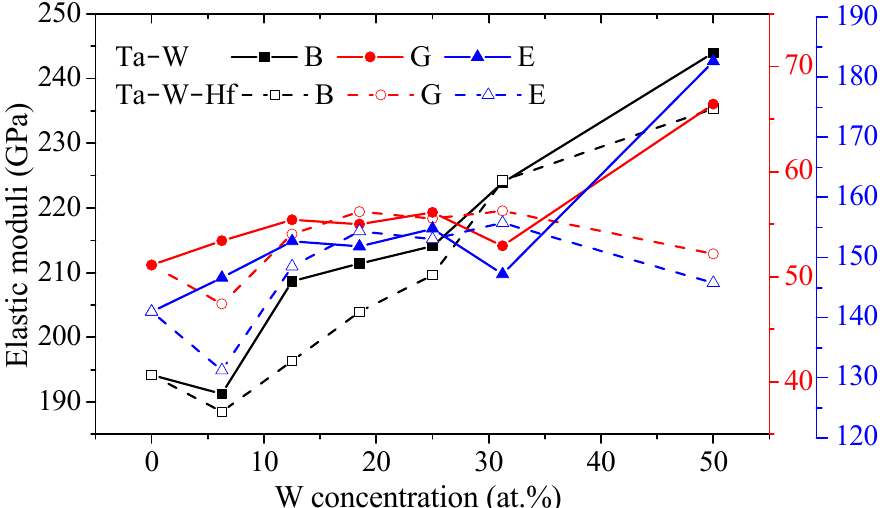
Figure 6. The calculated elastic constant of Ta–W alloys and Ta–W–Hf alloys with different W content (unit: GPa).